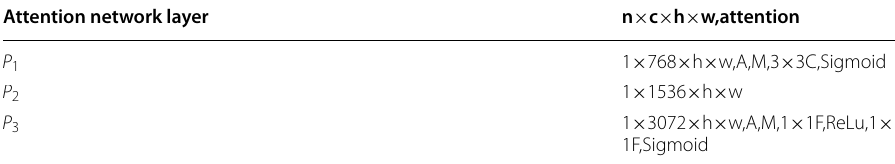
n denotes the number of filters, c denotes the channels of the filter, h/w denotes the size of the filter, A denotes the average pooling layer, M denotes the maximum pooling layer, C denotes the convolutional layer, and F denotes the fully connected layer